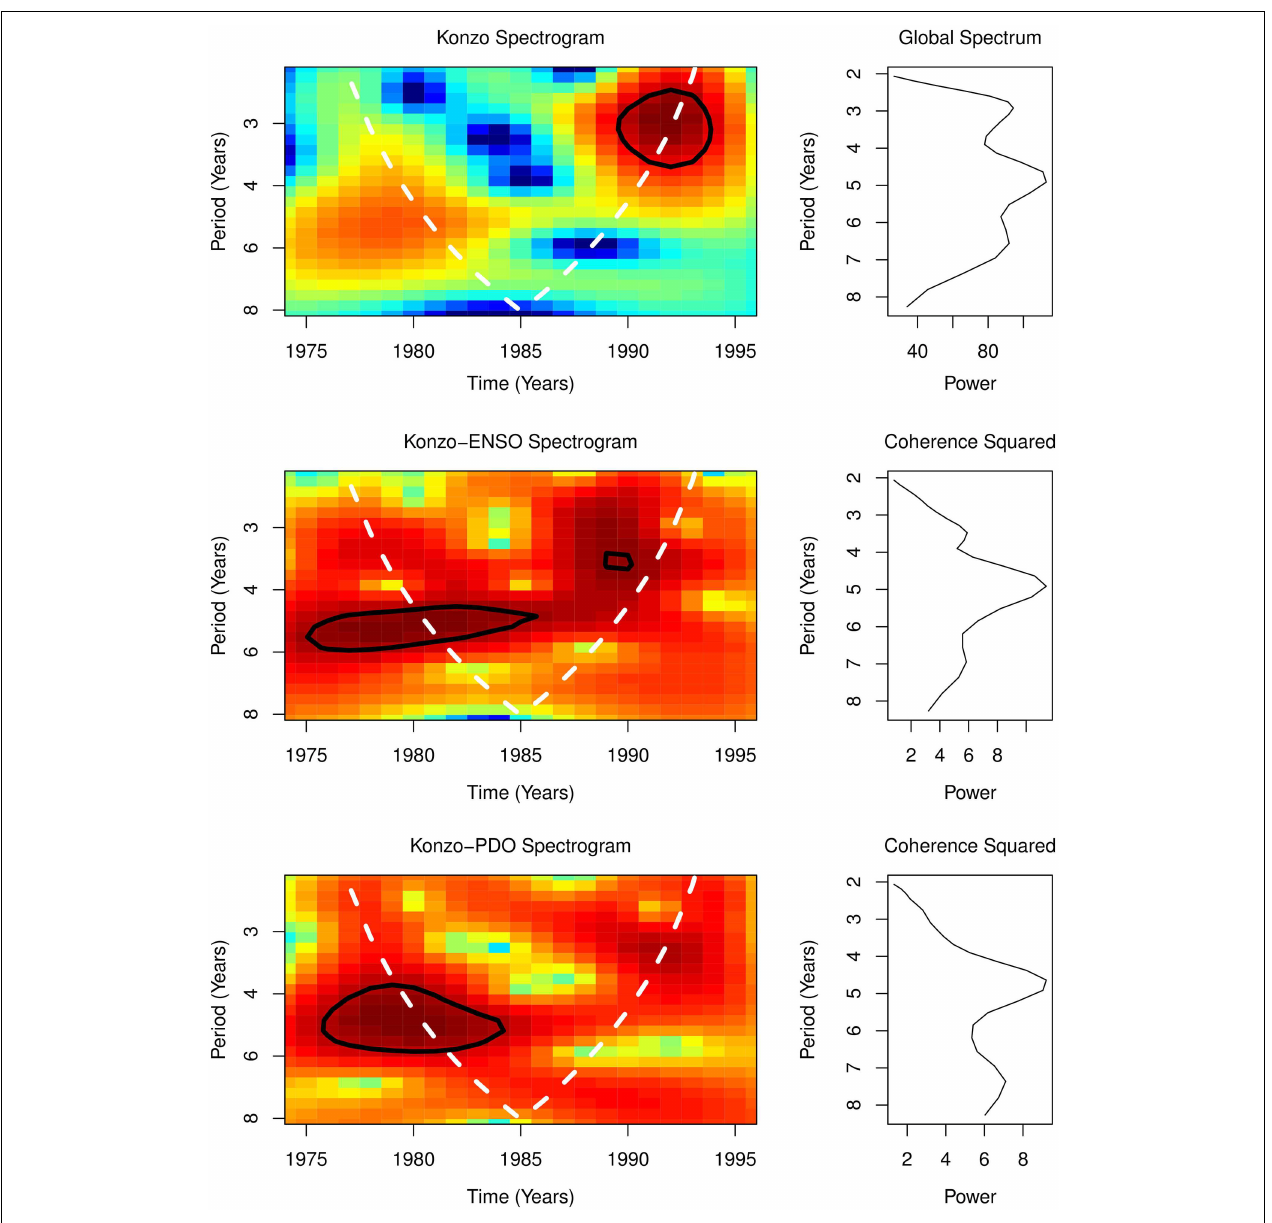
FIGURE 3 | Spectral